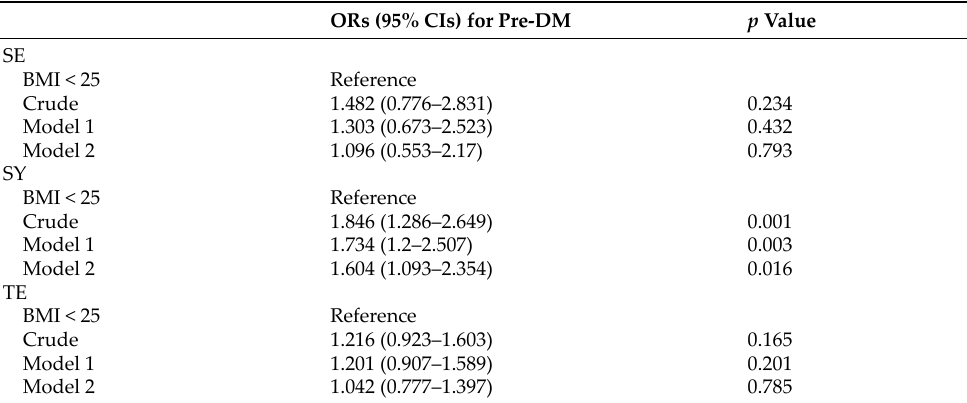
Table 4. Adjusted ORs (95% CIs) of the obese group compared with the normal BMI group for pre‑ DM among individuals with SE, SY and TE